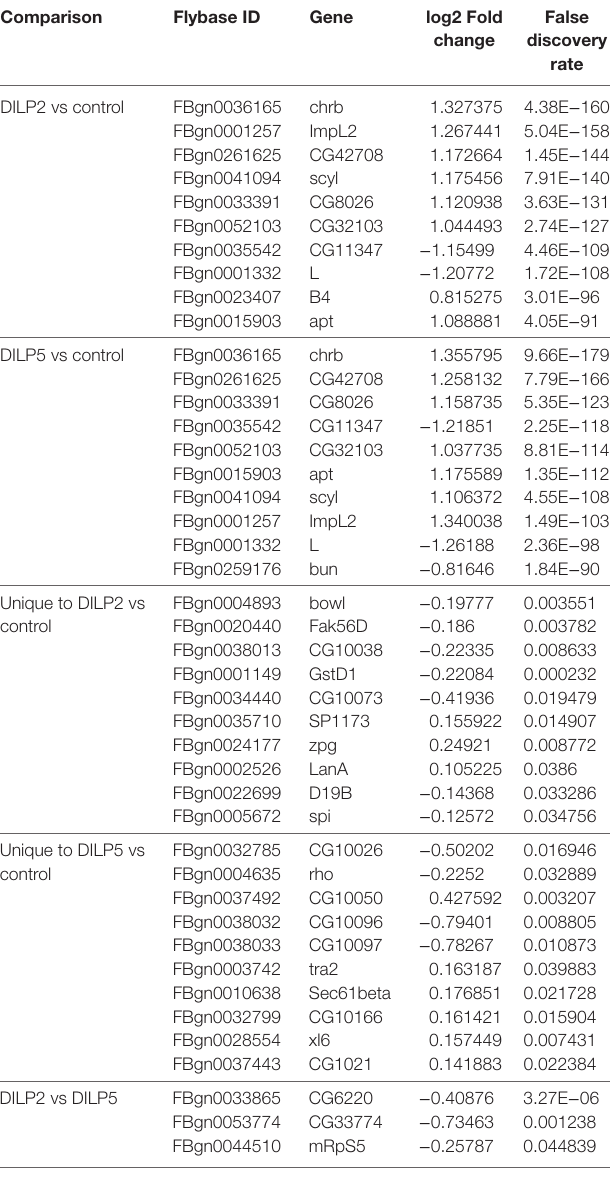
TaBle 1 | DE genes stimulated by Drosophila insulin-like peptide (DILP) 2 and DILP5: top 10 with statistical significance.